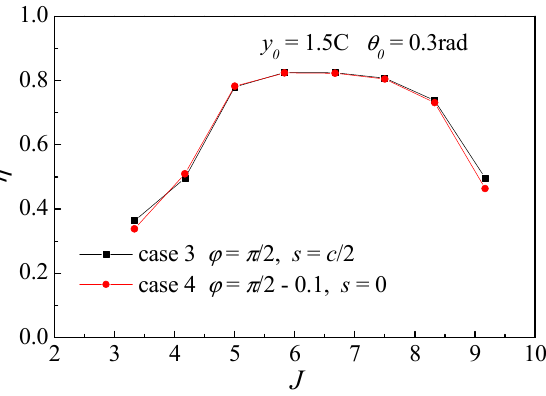
Figure 16. Comparison of propulsive efficiency between the Case 3 and Case 4.